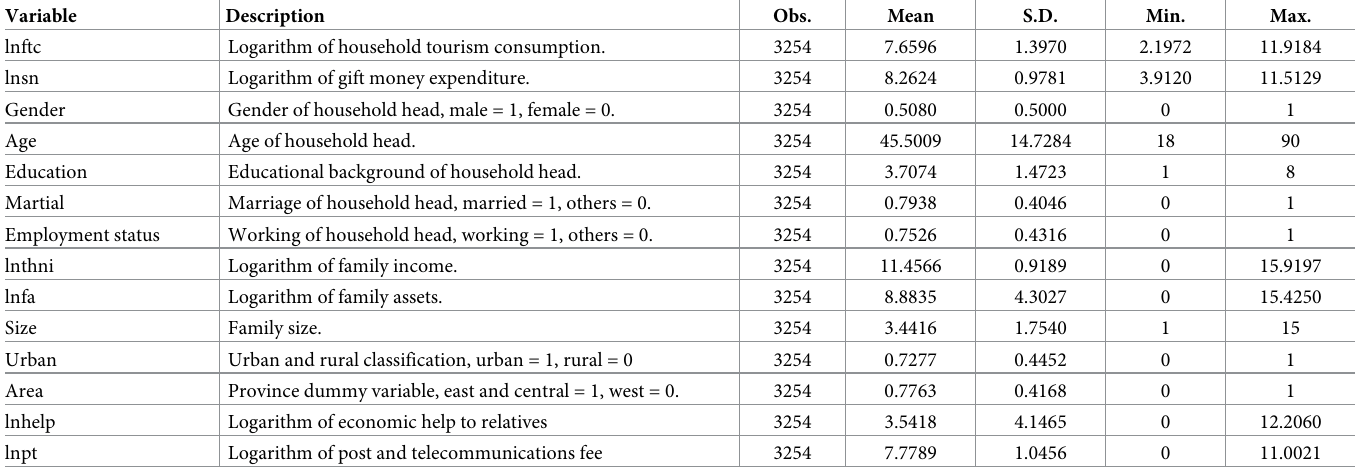
Table 1. Summary